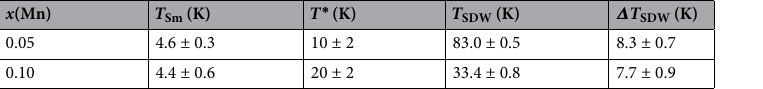
Table 1. Magnetic ordering temperatures: T Sm , T ∗ , T SDW and ∆ T SDW width determined by dc-magnetization, Hall effect and µ SR . The last two parameters were determined from an erf -model fit of the T -dependence of the magnetic volume fraction in the x = 0.05 and 0.10 case (see text for